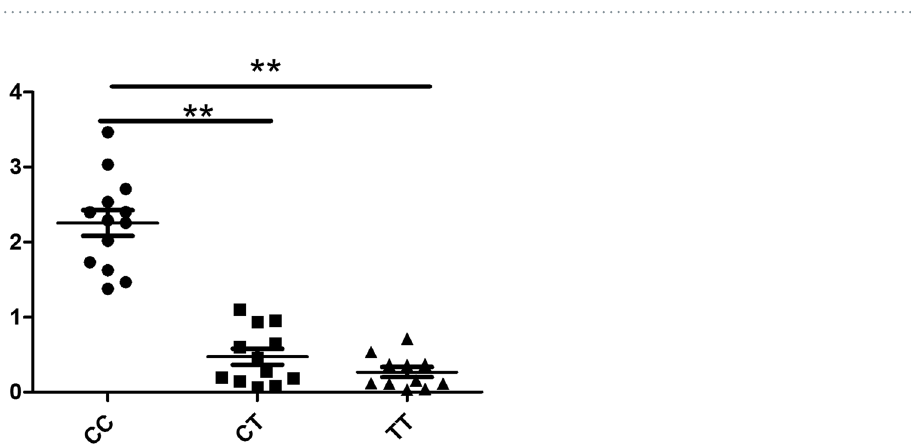
Figure 1. The influence of MBL2 /rs1800450 genotypes on the expression of MBL2 by PBMCs. MBL2 mRNA level in GG individuals of SNP rs1800450 was significantly higher than in AG individuals. Data are shown as mean ± SD. * P = 0.019 (GG/AG = 12).